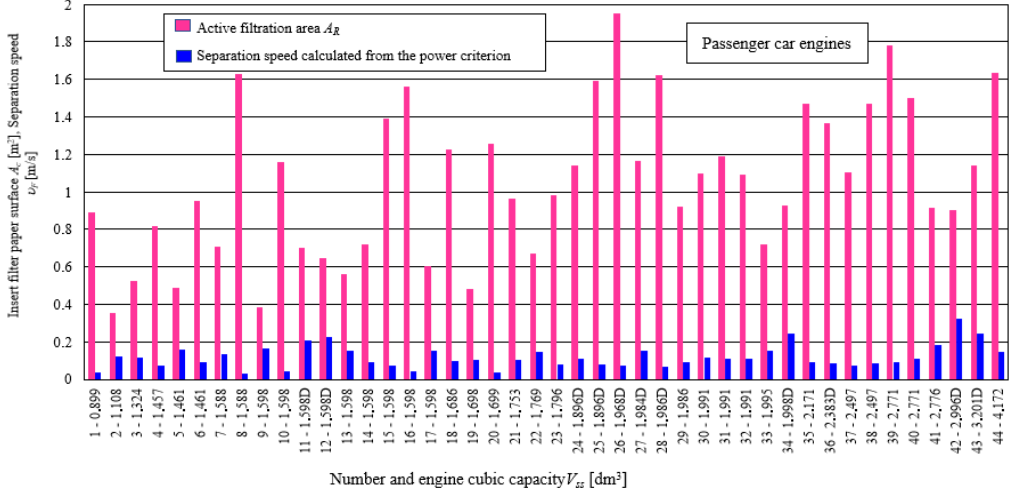
Fig. 8. Separation speed  N calculated on the basis of power criterion and active filtering surface A R in passenger car filter